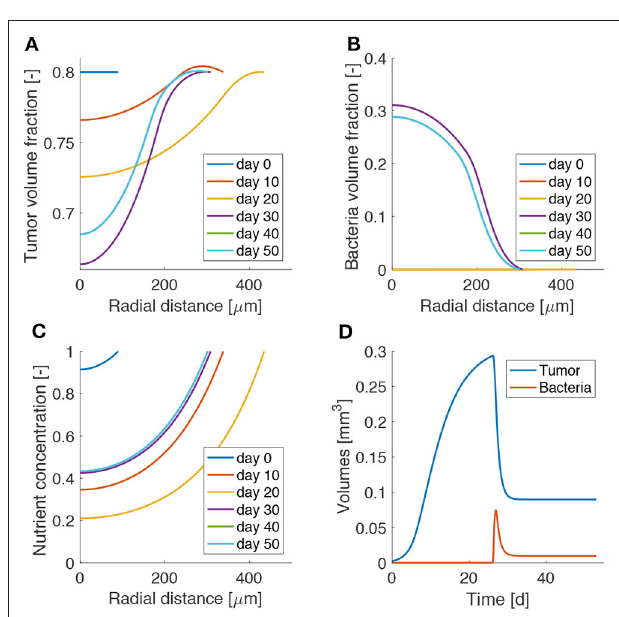
FIGURE 3 | Model results for bacteria administration to tumor spheroids. Spatio-temporal evolution of tumor (A) and bacteria (B) volume fractions and oxygen concentration (C) . (D) Temporal evolution of tumor and bacteria volumes in the spheroid. The lines for day 40 are behind those for day 50, as the spheroid has reached a steady